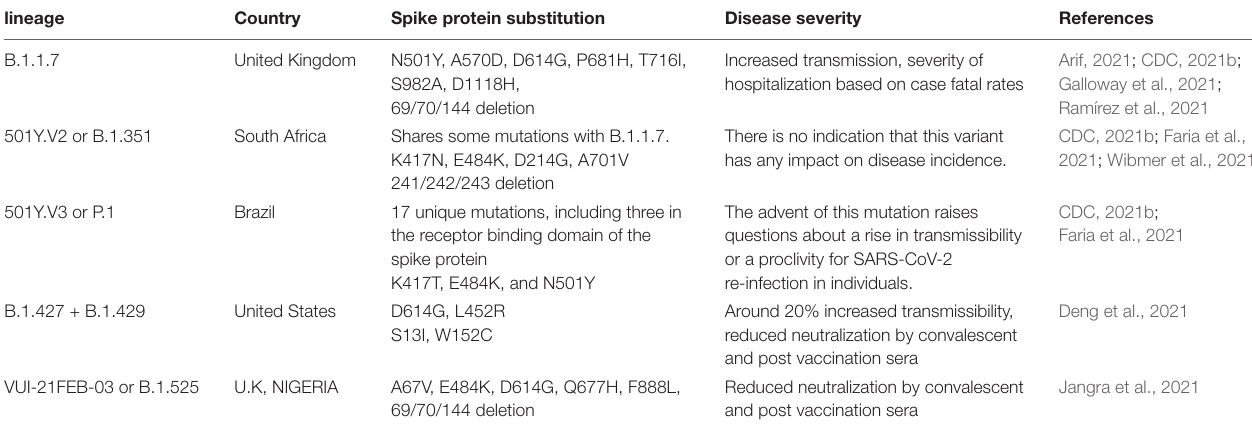
FIGURE 2 | The worldwide distribution of circulating SARS-CoV-2 lineages, (A) B.1.1.7, (B) B.1.351, (C) P.1, (D) B.1.429 + B.1.427, (E) B.1.525 on a time scale for South America, Europe United Kingdom, Oceania, North America, Global, Asia, Africa, and Europe-noUK. Source: https://www.gisaid.org/hcov19-variants/for the most recent global SARS-CoV-2 variant as of April 2021. TABLE 5 | Major SARS-CoV-2 lineage: research describes how often a vaccine will protect people affected by these